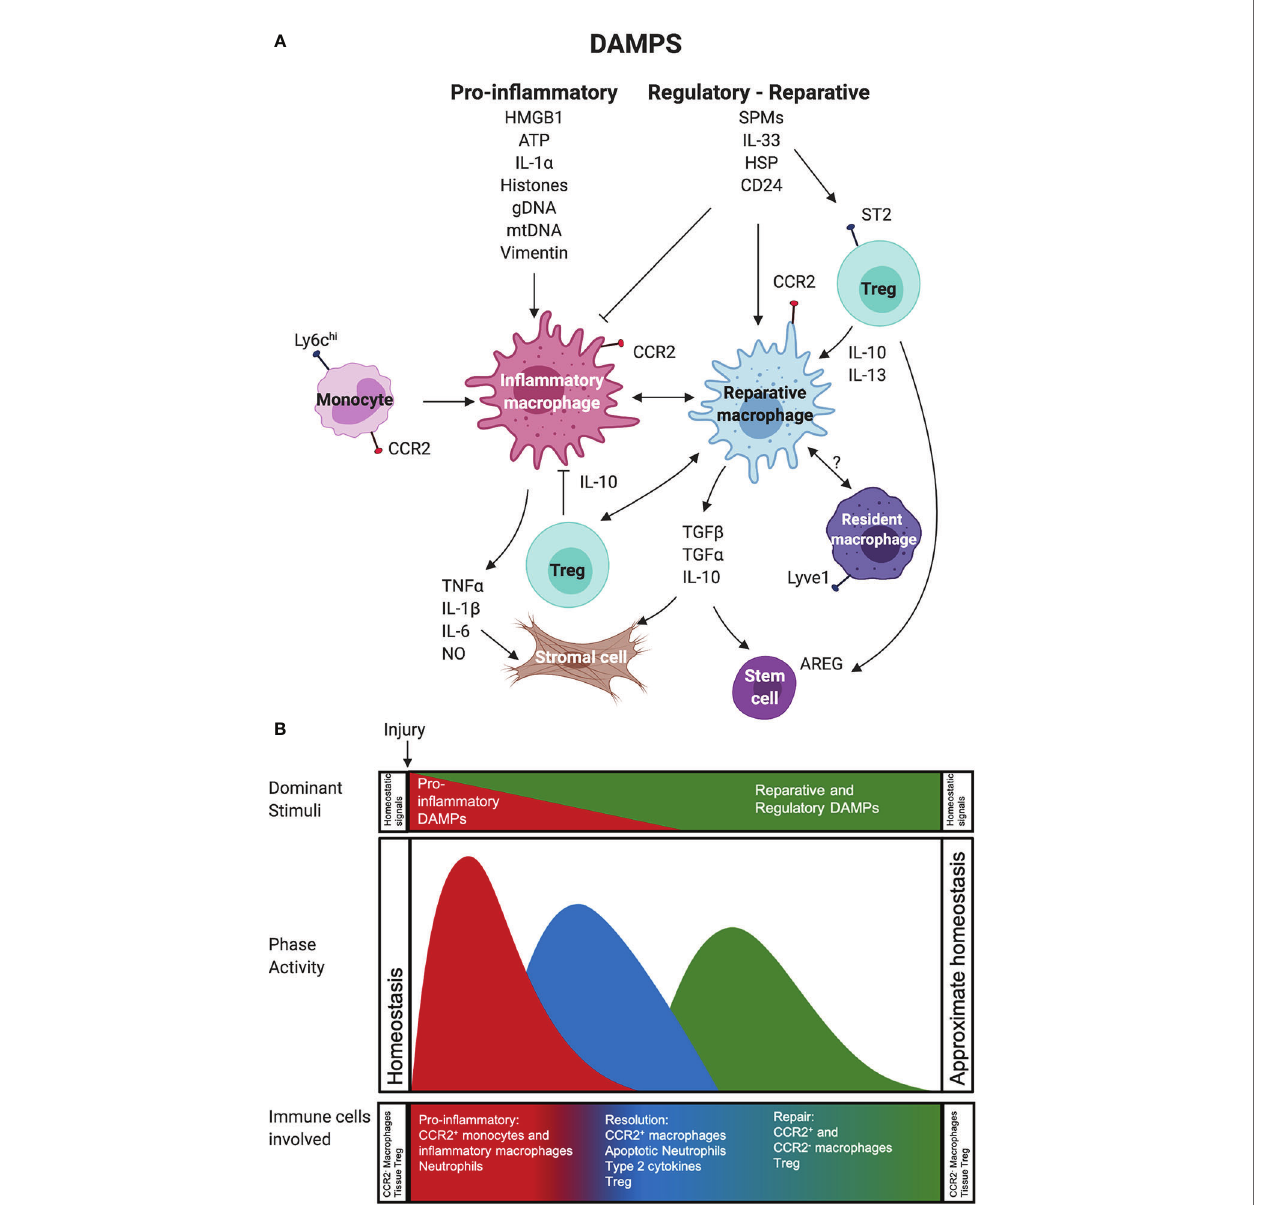
FIGURE 1 | Impact of pro-in fl ammatory versus reparative and regulatory DAMPs on immune cells during in fl ammation, resolution, and repair phases after tissue injury. (A) Recruited CCR2 + monocytes and the macrophages derived from them participate in a highly regulated, immune-mediated tissue repair process shaped by 1. Pro-in fl ammatory and 2. Reparative and Regulatory DAMPs. These also act on Treg and potentially resident macrophages to support the survival and function of these immune cells. (B) This process can be divided into three overlapping phases, including a: 1. pro-in fl ammatory phase (red), 2. resolution phase (blue), and 3. repair phase (green). In the fi rst phase, pro-in fl ammatory DAMPs act on monocytes and macrophages to generate or support the function of highly phagocytic, in fl ammatory macrophages that use robust production of NO and pro-in fl ammatory cytokines to mediate the removal of any pathogens and damaged necrotic tissue. The transition to the resolution phase involves efferocytosis, or the phagocytosis of apoptotic cells, by macrophages receiving input from reparative and regulatory DAMPs and type 2 cytokines. These can both block the impact of pro-in fl ammatory stimuli on macrophages and contribute to the generation of Treg that support local immune suppression. The fi nal phase involves little pro-in fl ammatory DAMP activity. It is dominated by reparative and regulatory DAMPs macrophage metabolism enabling the function of reparative and regulatory macrophages, such as secretion of cytokines, effector molecules, and growth factors that mediate responses in stromal, parenchymal cells, and stem cells to facilitate tissue repair. Regulatory and reparative DAMPs also act on Treg, which support the generation of reparative and regulatory macrophages and contribute growth factors to the repair environment. Reparative and Regulatory DAMP most likely also act on resident macrophages that are important for injury resolution and re-establishment and maintenance of tissue homeostasis. Abbreviations used: Areg, Amphiregulin; ATP, Adenosine Triphosphate; CCR2, CC Motif Receptor 2; DAMP, damage-associated molecular pattern; gDNA, Genomic DNA; HSP, Heat Shock Protein; HMGB1, High-mobility group box 1; IL, Interleukin; Ly6C, Lymphocyte antigen 6 complex, locus C1; mDNA, Mitochondrial DNA; NO, Nitric Oxide; SPM, Specialized pro- resolving mediators;TGF, Transforming growth factor; Treg, Regulatory T